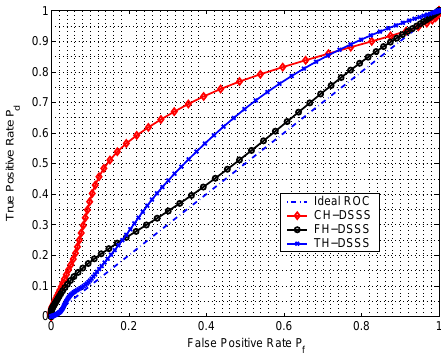
Figure 18: Hopping-based Spread Spectrum Tech-